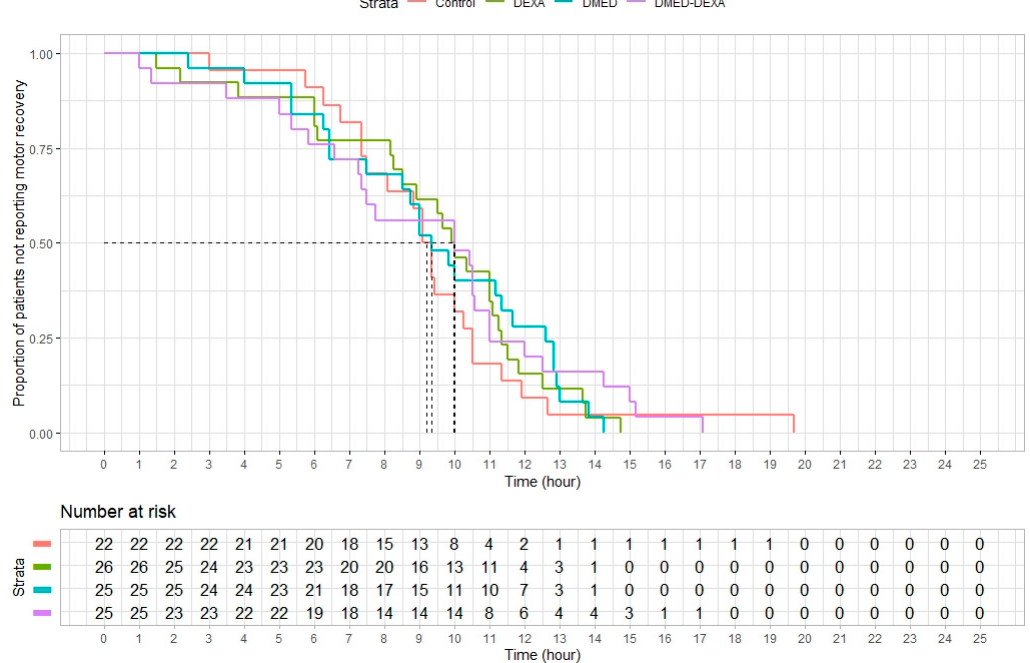
Figure A2. Survival analysis of the duration of motor blockade. The crossing points of the dotted and colored solid lines indicate median duration of the corresponding strata (groups). There was no difference in motor block duration ( p = 0.895).